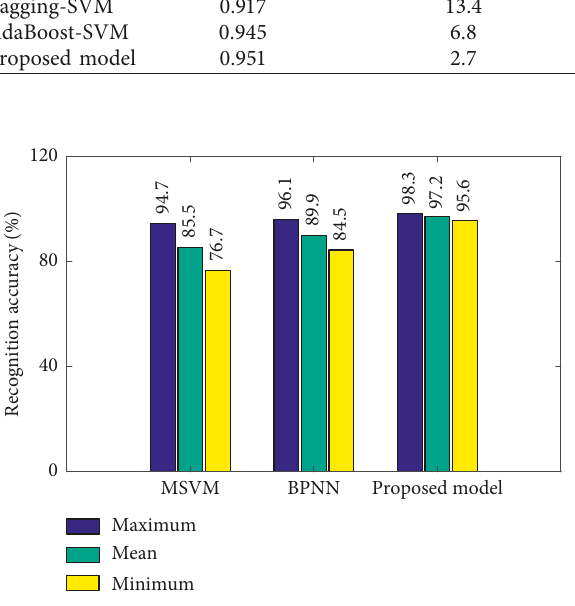
Figure 15: Comparison results of other single models. Table 10: Performance comparison with other single